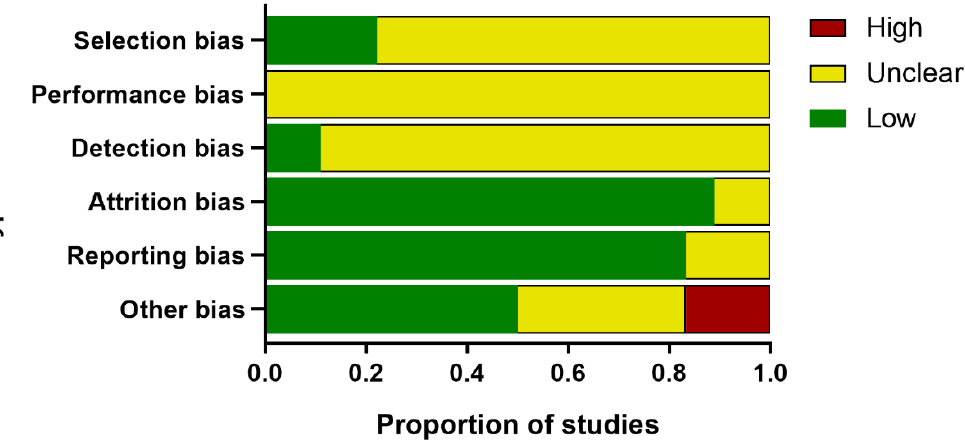
Figure 2. Study quality assessed through SYRCLE’s risk of bias tool for animal studies.